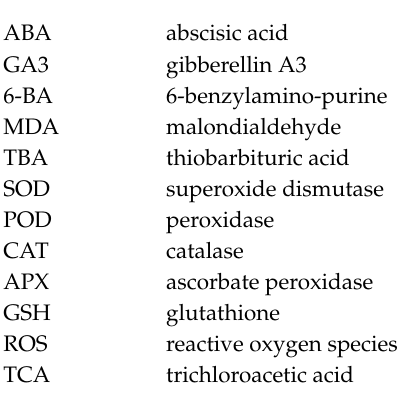
2754 / s1. Figure S1: Molecular Identification of Transgenic lines. Table S1: Primer sequences used for quantitative real time polymerase chain reaction